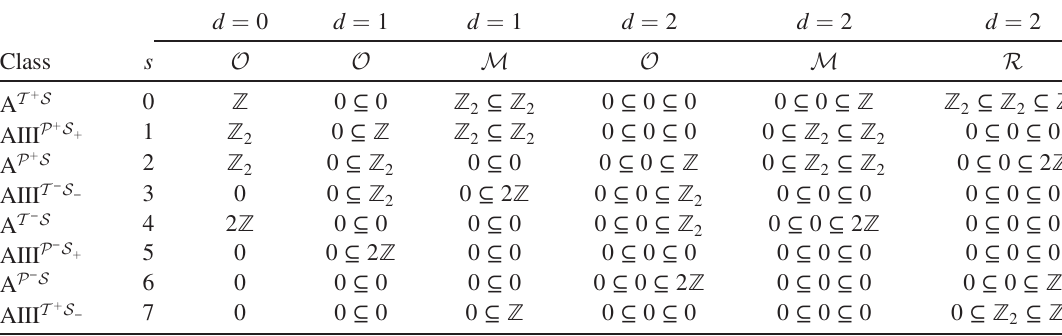
TABLE III. Same as Table II, but for antiunitary symmetries and